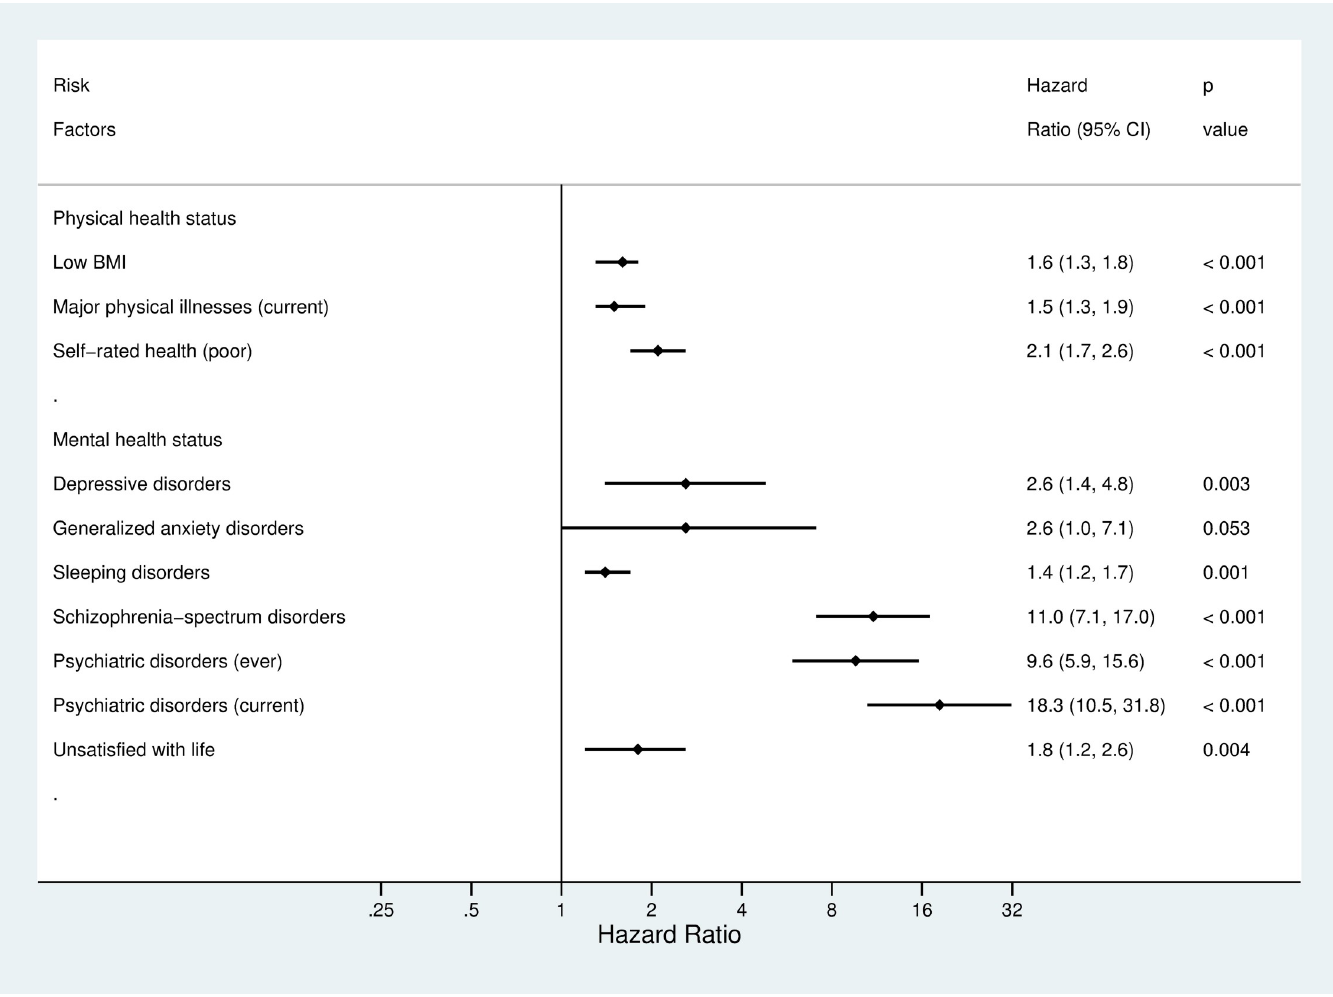
Fig 3. Hazard ratios for suicide by physical and mental health status. HRs adjusted for sex, age, rural residence, education, income, and single status. HR, hazard ratio; BMI, body mass index.